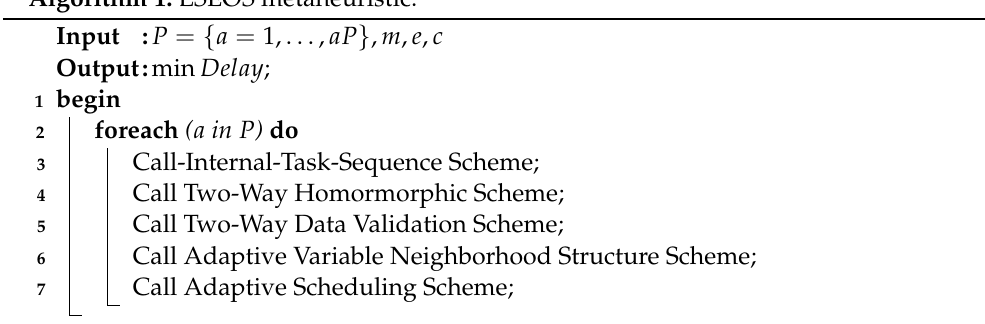
Algorithm 1: LSEOS